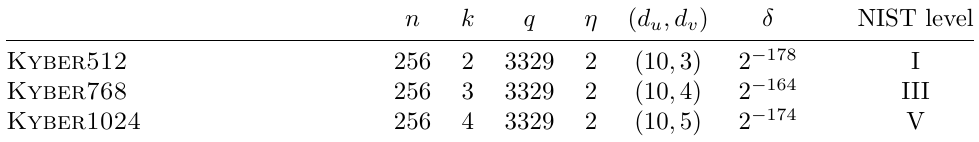
Table 2: Kyber parameter sets (see [ABD + 19]). The failure probability is given as δ